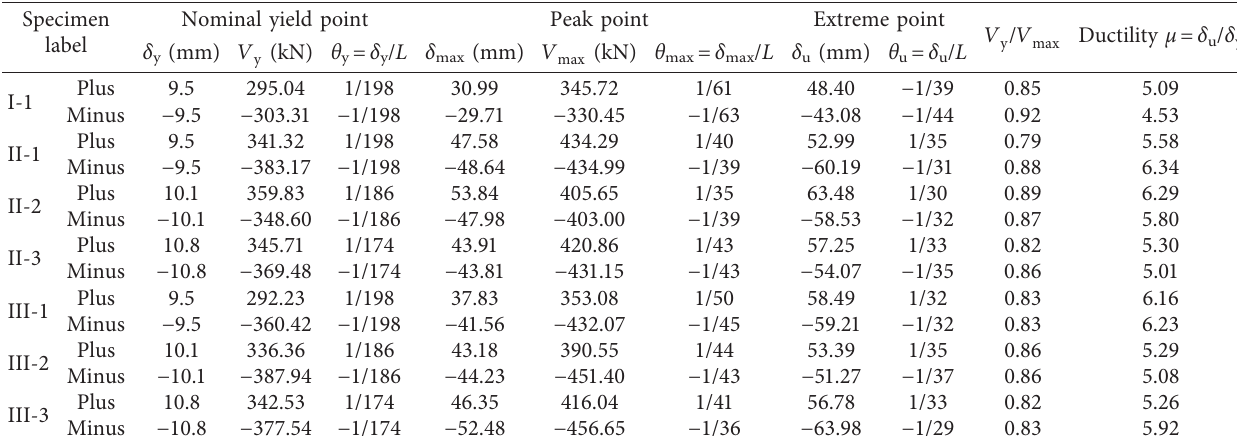
Figure 9: Skeleton curves of the specimens. (a) Effects of installing buckling-restrained energy dissipation wall plates. (b) Effects of axial compression ratio n . (c) Effects of eccentricity e . Table 3: Results about loading bearing and deformation of pseudostatic